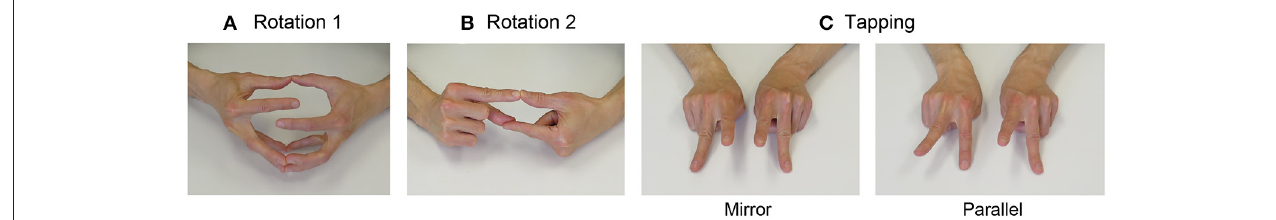
FIGURE 1 | Snapshots of each finger movement task. (A) Rotation task 1. Both hands were connected at the ball of each finger. Participants were then instructed to disconnect one pair of fingers and rotate them five times without separating the other finger pairs. Subsequently, in a similar manner, they rotated the pair five times in the opposite direction (for a total of 10 rotations). They were instructed to perform this movement as fast as possible, without disconnecting the other pairs of fingers. The picture example shows a pair of index fingers. They were instructed to make 10 rotations for each pair of thumbs, index, middle, annular, and fifth fingers. (B) Rotation task 2. The right index finger and left thumb were connected at the ball, and similarly, the left index finger and right thumb were connected at the ball. The other fingers were closed. First, one lower index finger/thumb pair was disconnected, and rotated upward, and was then connected again. Subsequently, the other index finger/thumb pair located below was disconnected, and was rotated upward, and connected again. Participants were instructed to perform this movement for 15s as fast as possible. The same procedure was applied to all of the four pairs (index finger and thumb, middle finger and thumb, annular finger and thumb, and fifth finger and thumb). (C) Tapping task. In the Mirror task, the two index fingers of both hands were raised, and subsequently, the index fingers were lowered whilst simultaneously raising the middle fingers. In the Parallel task, the same movement was performed with the pair of the right index and left middle fingers, and the pair of the left index and right middle fingers. Participants were instructed to perform these movements for 30s as fast as possible.